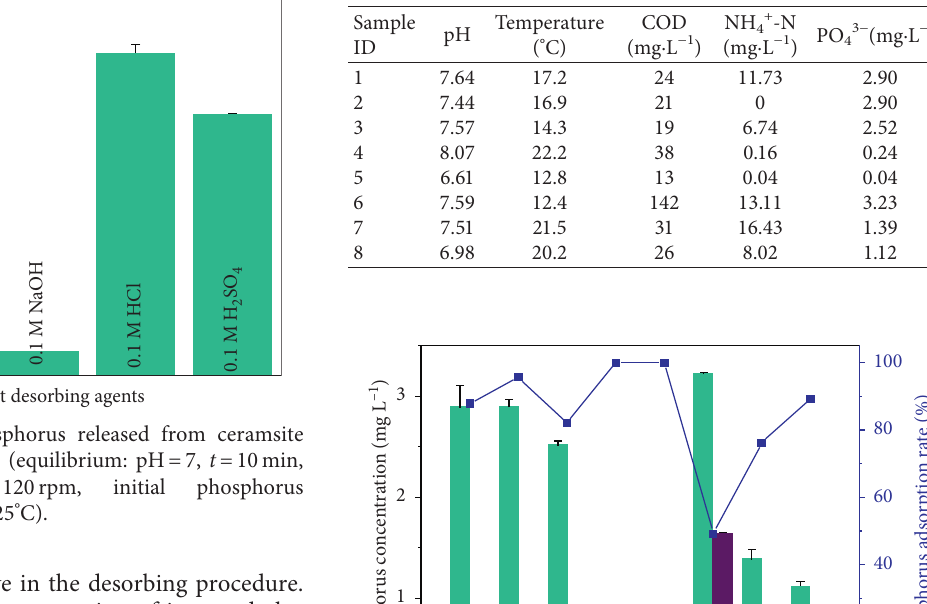
Table 7: Details of collected water samples.